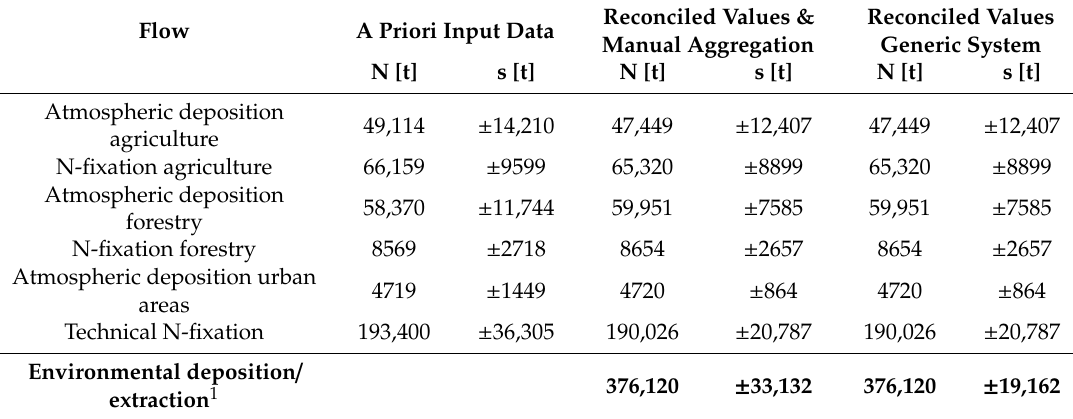
Table 2. Input data and reconciled values for environmental deposition / extraction in the Austrian N system when manually aggregating individual flows, using Equation 5 as a proxy for standard uncertainty and when computing value and uncertainty of the aggregated flow in the generic structure using